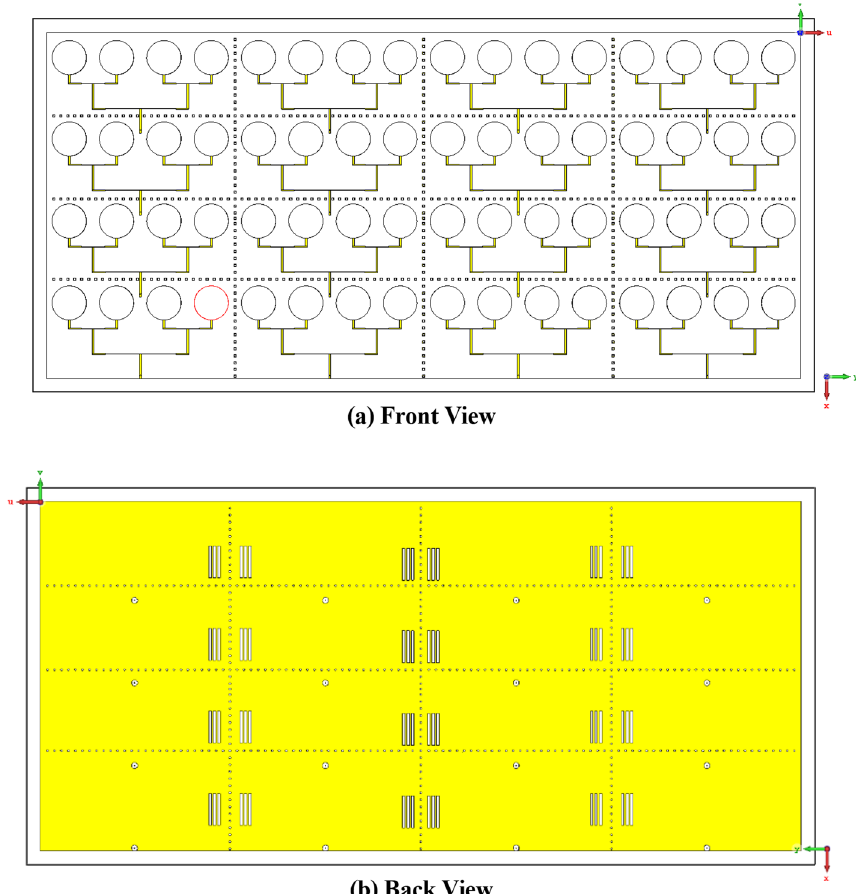
Fig. 6 Design of 8 8 massive MIMO antenna using ×